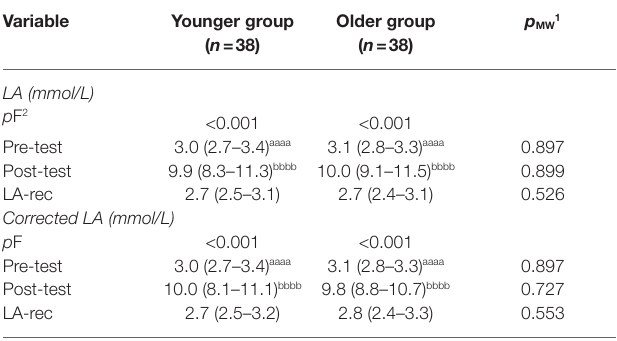
TABLE 2 | Concentration of lactic acid (LA) of the participants’ blood samples. Variable Younger group ( n =